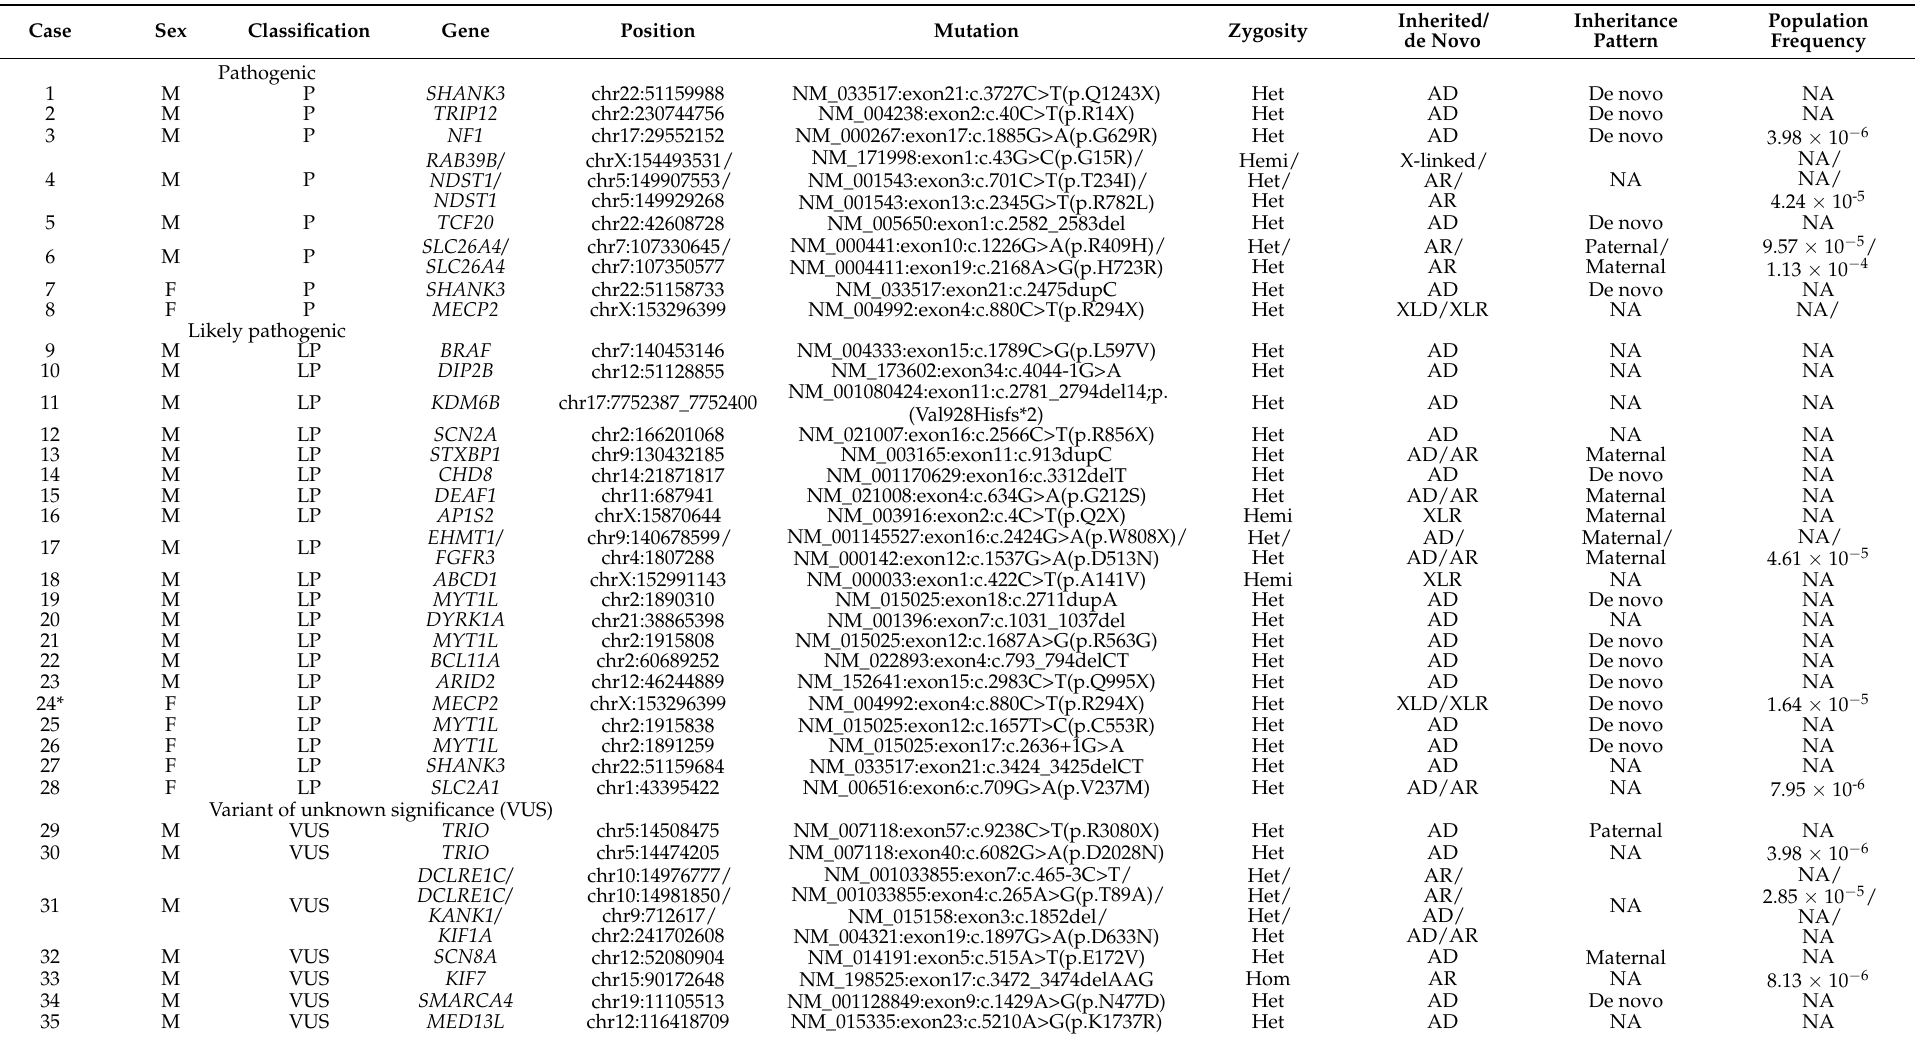
Table 1. SNVs identified from ASD patients from